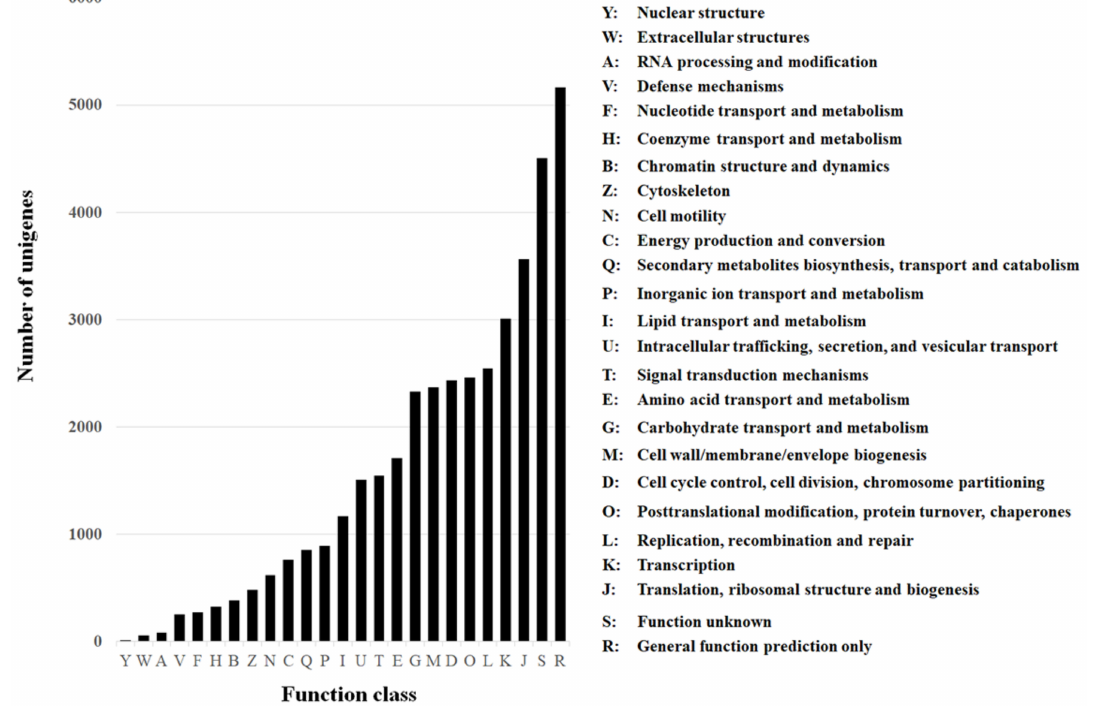
Figure 2. Cluster of Orthologous Groups (COG) of the unigenes obtained from sequencing the resistant and susceptible samples used in this